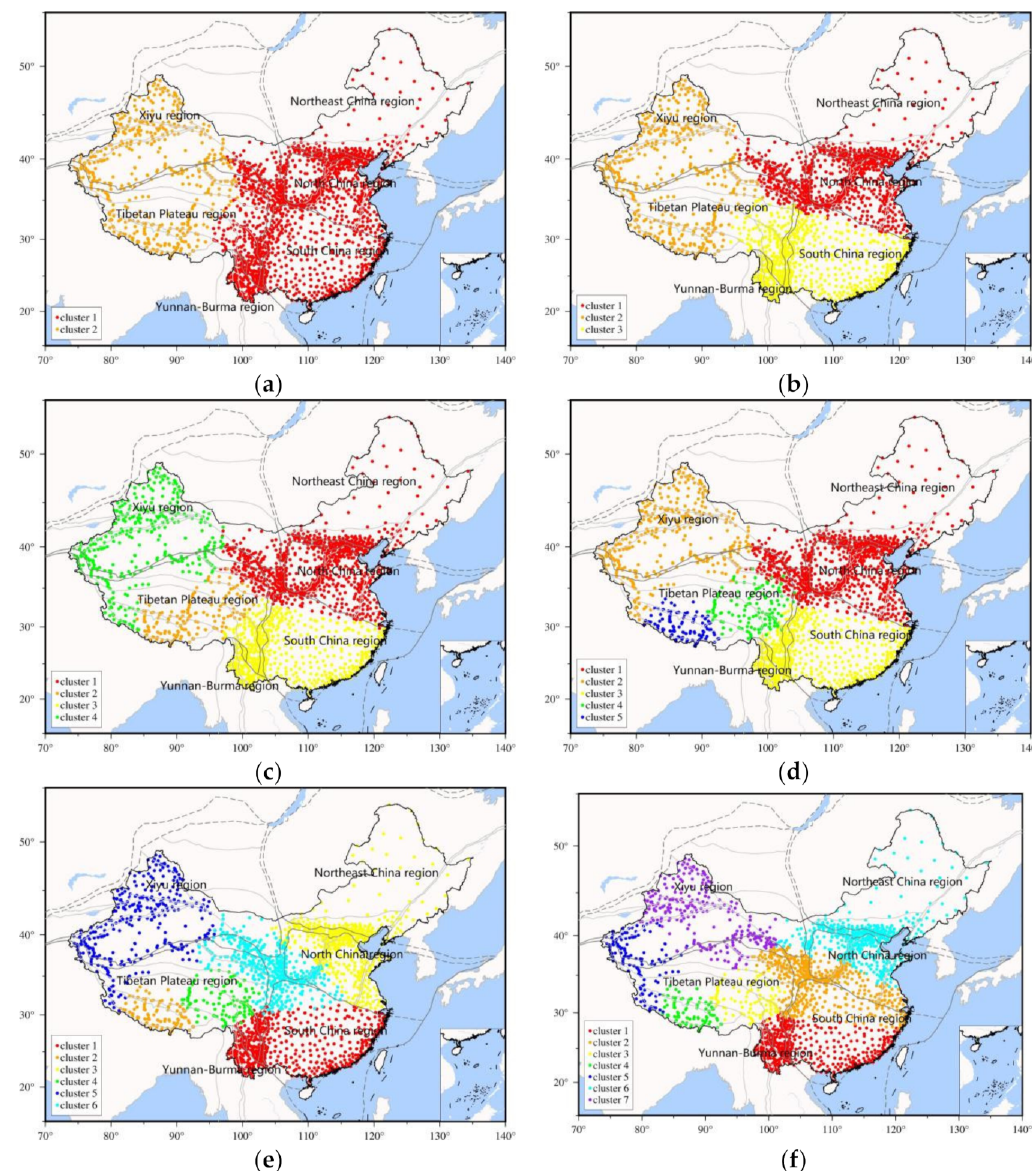
Figure 11. The results of block division with improved K-means++ clustering method. ( a ) Two clusters. ( b ) Three clusters. ( c ) Four clusters. ( d ) Five clusters. ( e ) Six clusters. ( f ) Seven